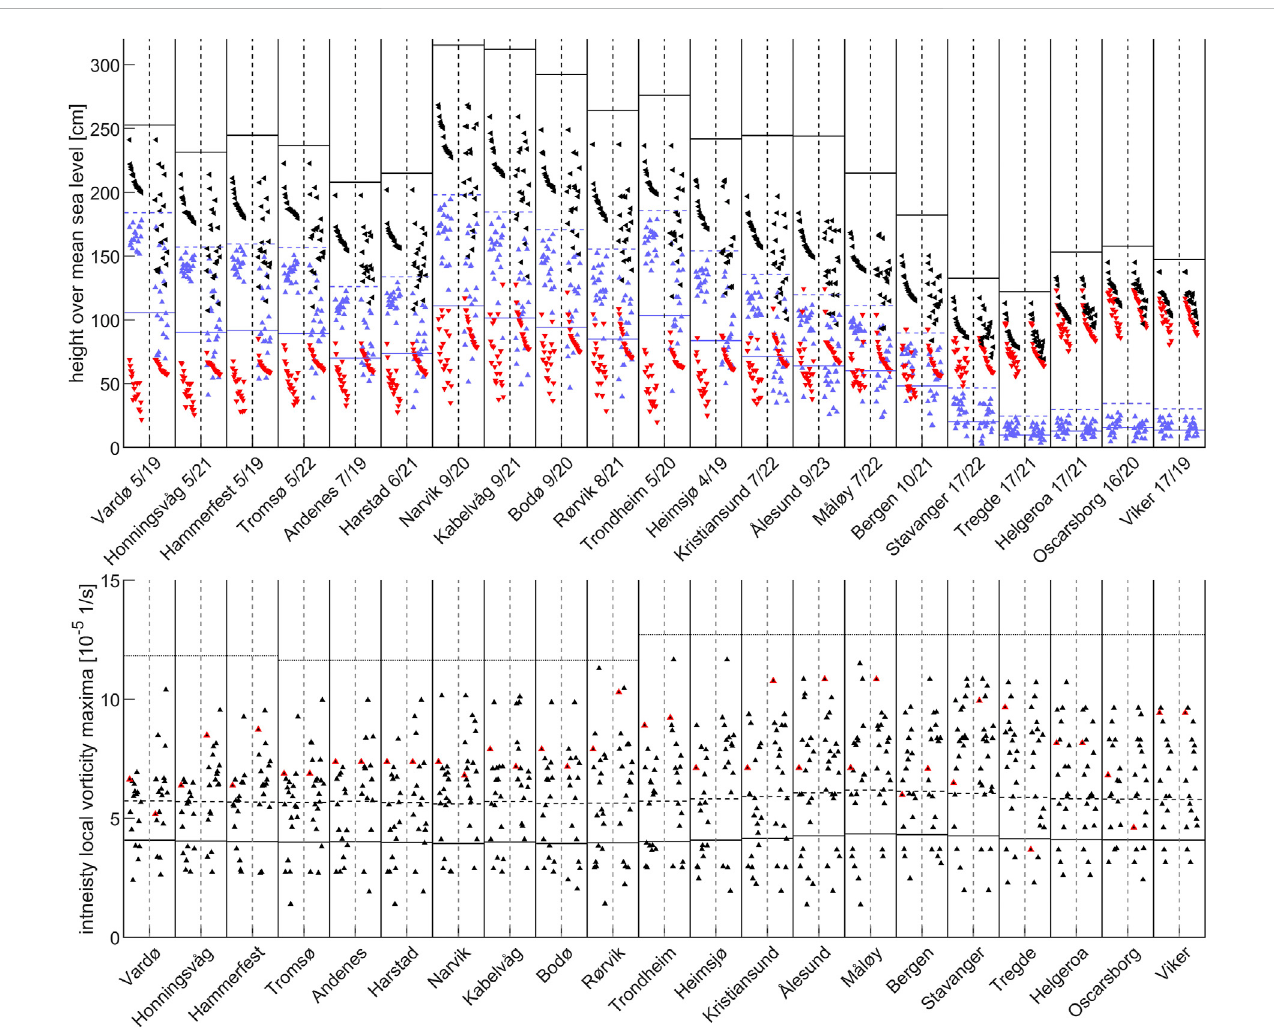
FIGURE 2 Upper panel: Observed SL maxima (black), SkS maxima (red) and AT maxima (blue) during each tidal cycle. Left and right columns for each TG show the 99.9th percentile of the SL maxima and SkSs, respectively. Numbers after the station names state the number of cases, where the 99.9th percentile is exceeded for both SkSs and the observed SL during a period ± 48 h from each other/the total number of cases, where the 99.9th percentile is exceeded for SkSs only. Blue lines mark the mean (solid) and maximum observed (dashed) AT for each TG. Black lines mark the maximum combination of AT and SkS irrespective of temporal overlap. Lower panel: Storm intensities of the nearest center point for the same cases as above. The cases with the highest observed SL(left column) and SkS(rightcolumn) are marked inred.The blacklines mark themean (solid), mean+ 1 standard deviation(dashed), and maximum (dotted) storm track intensity within 500 km from each